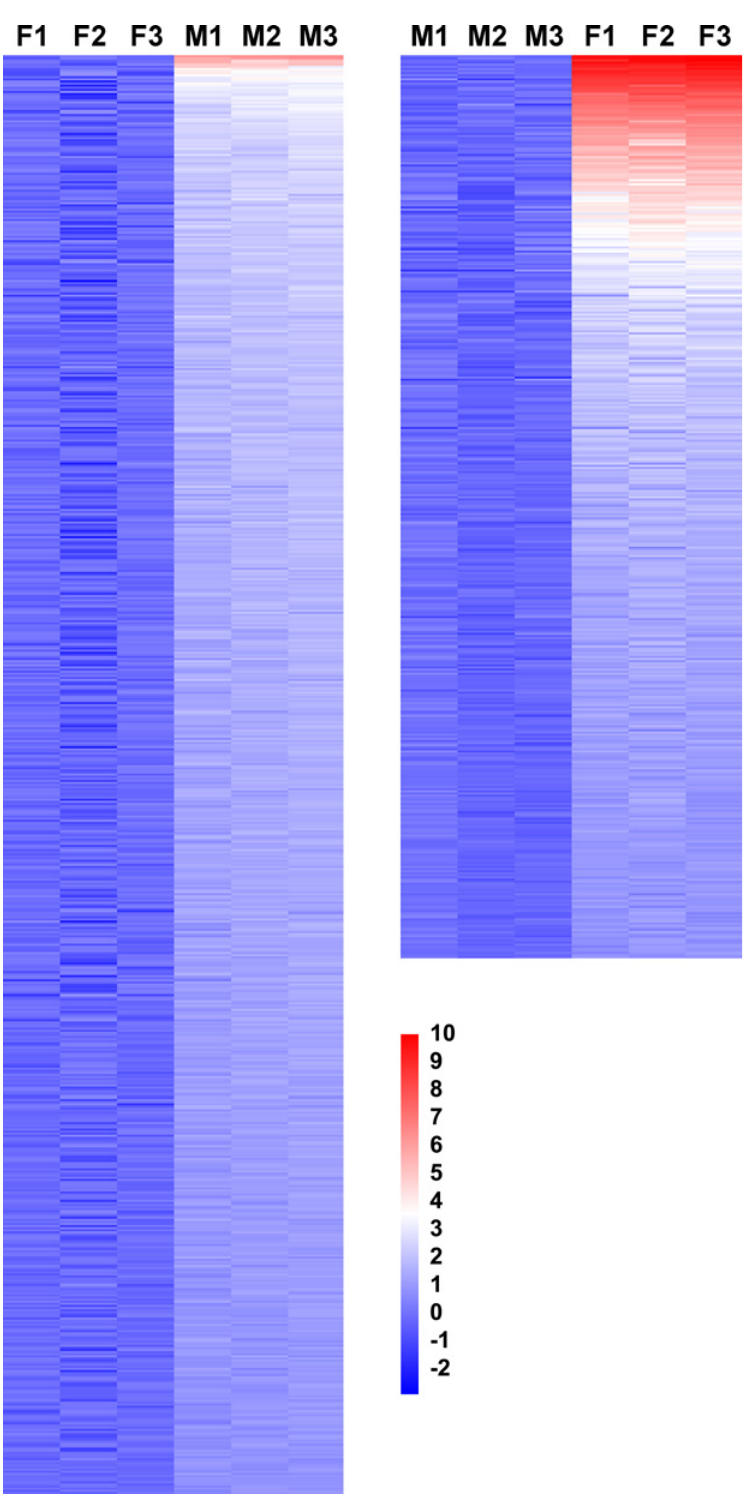
Fig 1. Heatmap for the gender-biased expressed genes determined by probes designed based on genomic and transcriptomic, but not EST sequences. A total of 685 and 430 genes are adult male-biased (left panel) and female-biased (right panel) in their expression, respectively. The presented data are based on the signal intensity of forward sequences. The heatmap was constructed based on the transformed data of log 2 fold change data. Three biological replicates are